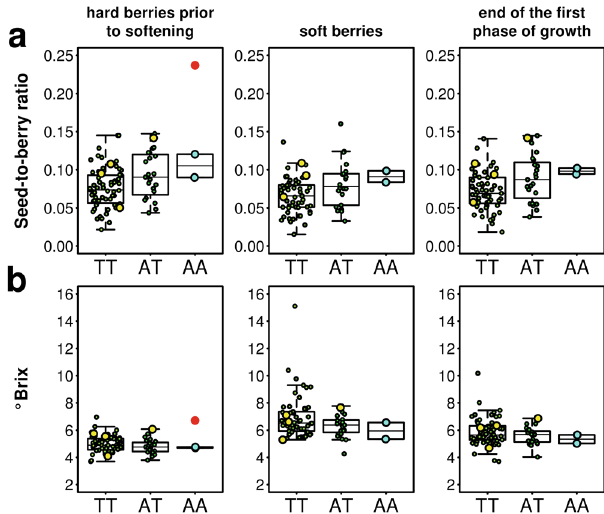
Fig. 6 Association analysis between SNPs and seed-to-berry ratio at the onset of berry ripening. a Association between a A → T mutation in the VIT_217s0000g05570 gene, which recapitulate the increase in berry – speci fi c expression of the kinase, and seed-to-berry ratio in hard berries prior to softening, soft berries collected over the same bunch and their average (as a proxy for the end of the fi rst phase of berry growth). Box-plots show 88 accessions (green dots) sorted by their genotype at the SNP_chr17:6,079,793. Accessions with missing AA, AT, TT genotypes were classi fi ed based on their alternate/alternate, alternate/reference and reference/reference genotypes, respectively, at the variant sites chr17:6,080,166; 6,079,793; 6,080,193; 6,080,258; 6,080,447; 6,080,449, which are all in LD with chr17: 6,079,793 in the H1-A haplotype. b Variation in soluble solids concentration in the same berries and accessions as in a . Red dots indicate values in hard berries of sylvestris V395. Yellow dots indicate values in eastern feral grapes. Cyan dots indicate values in Berzamino and Gordin Verde. Boxes indicate the fi rst and third quartiles, the horizontal line within the boxes indicates the median and the whiskers indicate ±1.5 × interquartile range. Source data are provided as a Source Data fi